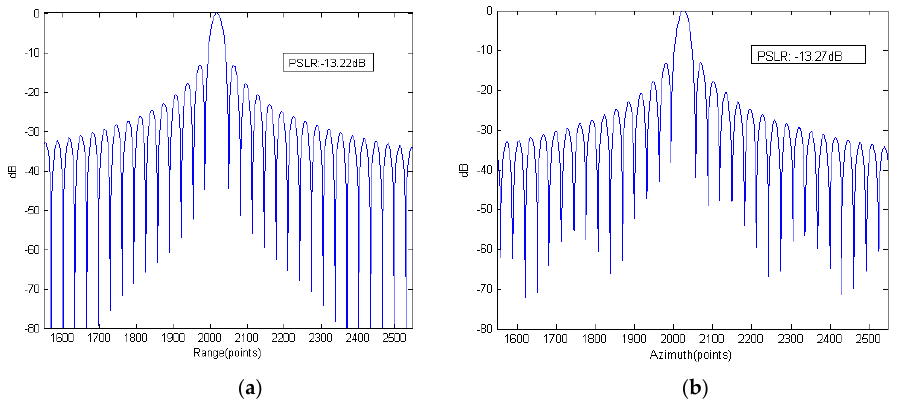
Figure 10. Range and azimuth slices of point C: ( a ) range slice and ( b ) azimuth slice.